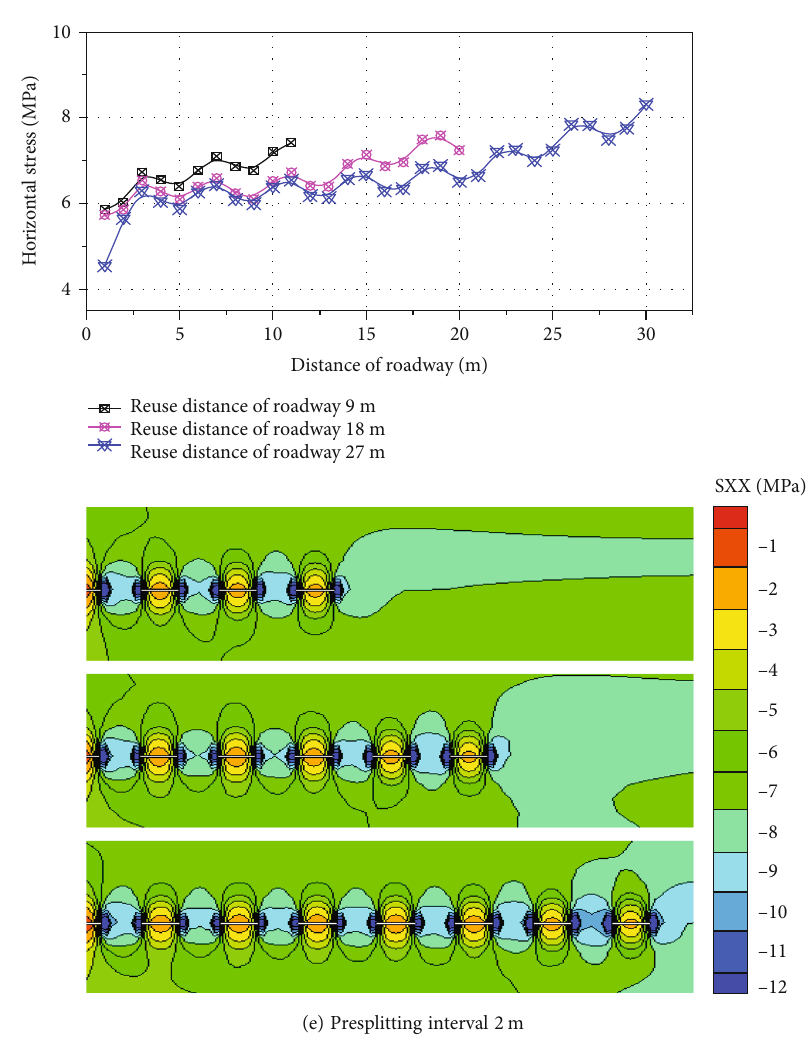
Figure 5: Horizontal tensile stress curve and stress nephogram of the presplitting